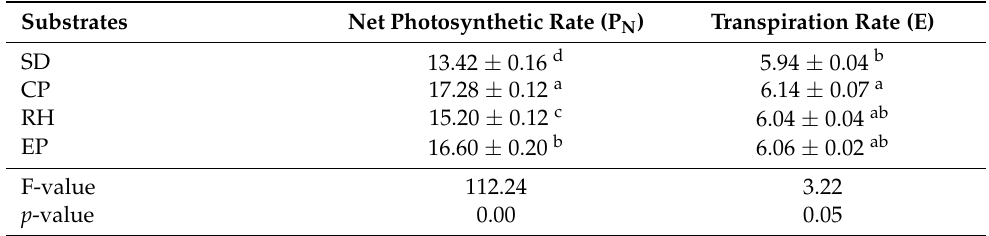
Table 6. Net photosynthetic and transpiration rate in lettuce leaf under different growing